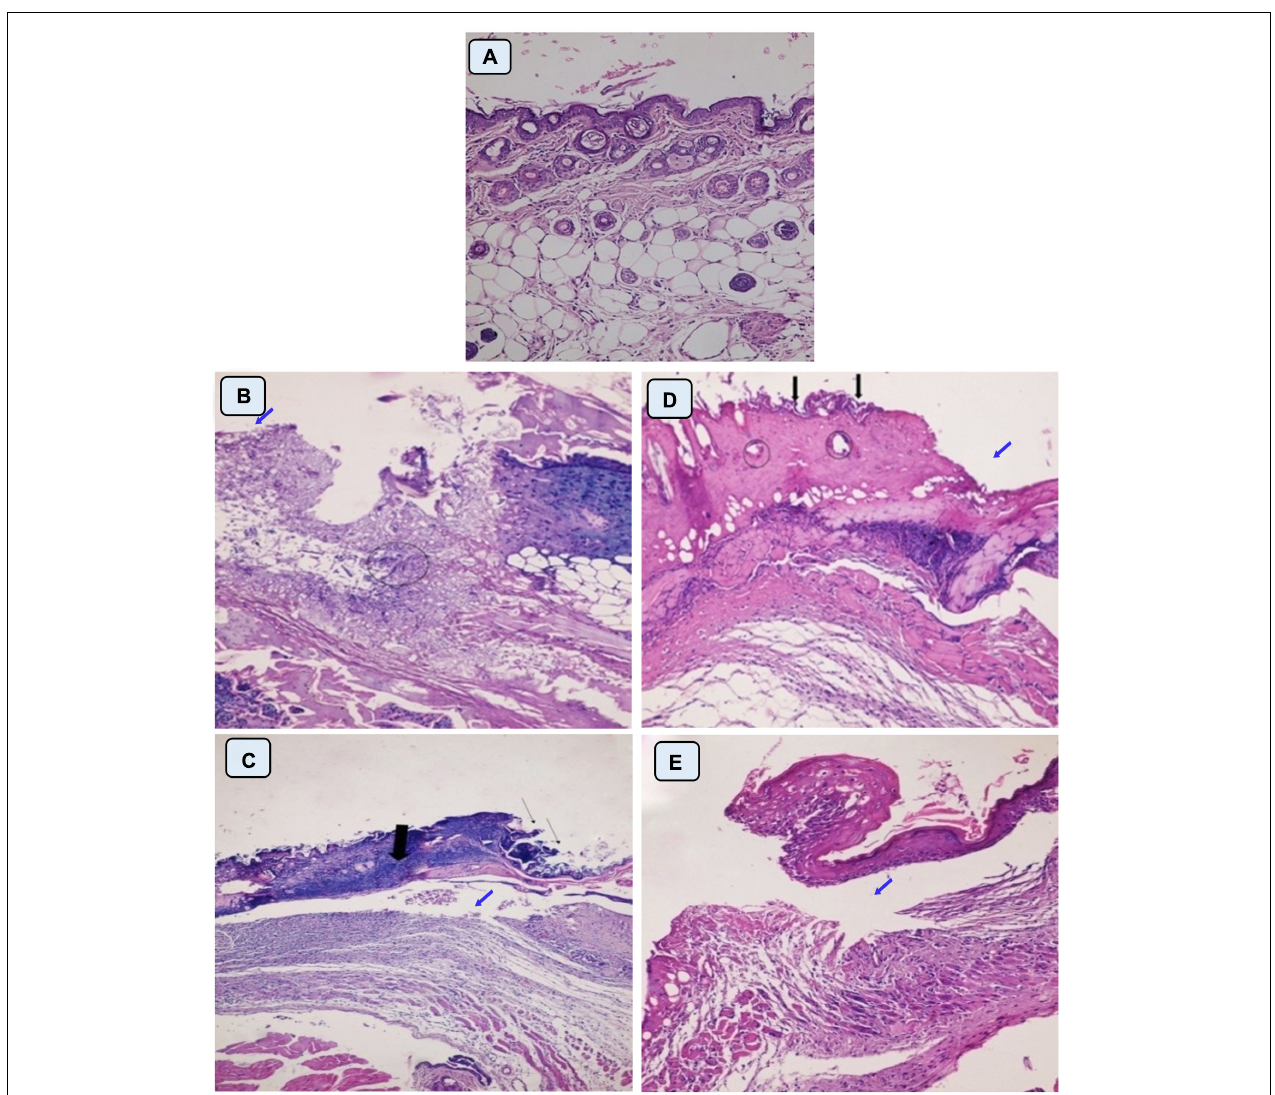
FIGURE 8 | Histopathological examination of skin mice of control groups during 1st stage (B,C) and 2nd stage of treatment (D,E) . G1 is negative control comprised neither burned nor infected mice (A) . G2 is positive control; mice skin were burnt and get infected with P. aeruginosa P8 without receiving any treatment (B,D) . G3 is positive control; mice skin were burnt, and get infected with P. aeruginosa P8 and received treatment with placebo gel only (C,E) . Magnification power (200 × ). (B) Loss of epidermis (blue arrow), distortion in the dermis layer with irregular distribution of collagen (circle). (C) Epidermis loss (thin arrow), underlying massive infiltration (thick arrow), and edema space in the dermis layer (blue arrow). (D) Irregular epidermis layer, infiltration with inflammatory cells (black arrow) with distortion in the glands within the dermis layer (circle), and large lytic area (blue arrow). (E) Separation of epidermis from the dermis layer with underlying inflammatory cells and irregular distribution of collagen in dermis layer underlying edema space (blue